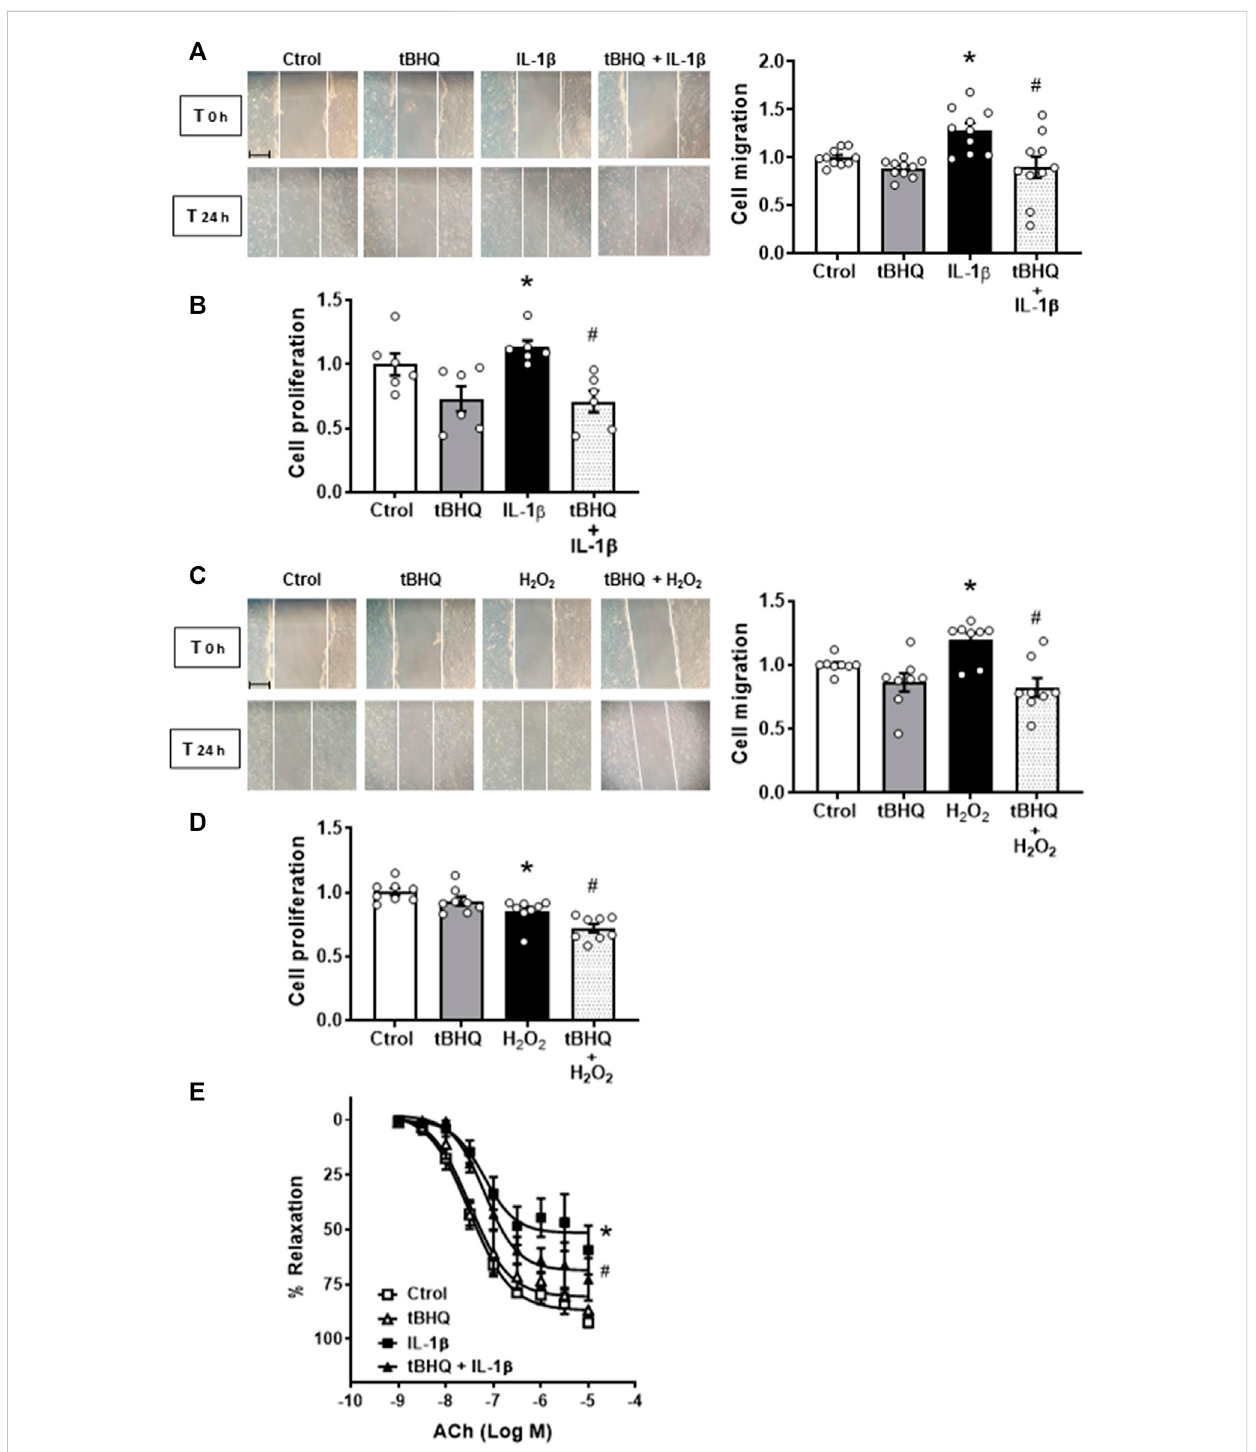
Modulation by Nrf2 activation of the IL-1 β - and H 2 O 2 -induced effects on cell migration and proliferation as well as on IL-1 β -induced endothelial dysfunction. Effect of tert-butylhydroquinone (tBHQ, 20 μ M, 24 h), Interleukin-1 β (IL-1 β , 10 ng/mL, 1 h) and tBHQ + IL-1 β (A,B) and tBHQ, hydrogen peroxide (H 2 O 2 , 100 μ M, 1 h) and tBHQ + H 2 O 2 (C,D) on cell migration and proliferation in vascular smooth muscle cells. Images of cell migration by woundhealingassayareincluded;barscalerepresents50 μ m.* p < 0.05vs.control;# p < 0.05vs.IL-1 β byStudent ’ s t -test( n =6 – 10).EffectoftBHQ, IL-1 β (10 ng/mL, 24 h) and tBHQ + IL-1 β on acetylcholine (ACh)-induced relaxation in mice aortic segments precontracted with phenylephrine (E) . * p < 0.05 vs. control; # p < 0.05 vs. IL-1 β by two-way ANOVA followed by Bonferroni ’ s post test ( n =